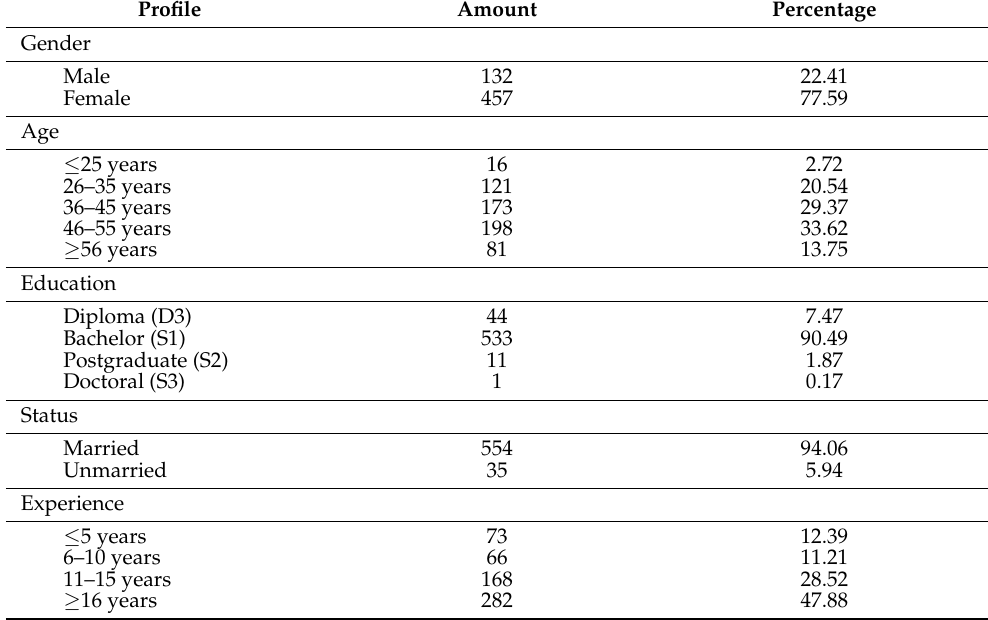
Table 1. The research participants’